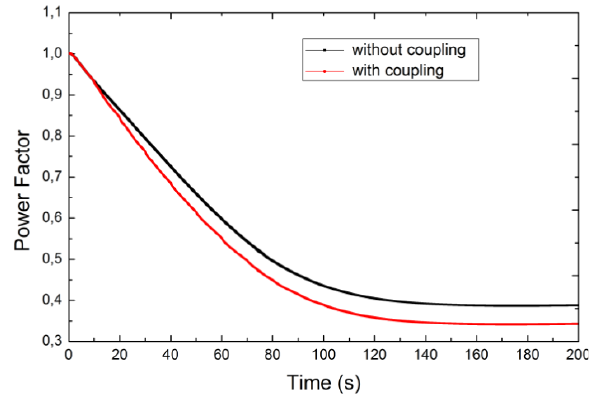
Fig. 16. Power during ULOF/PP accident with and without